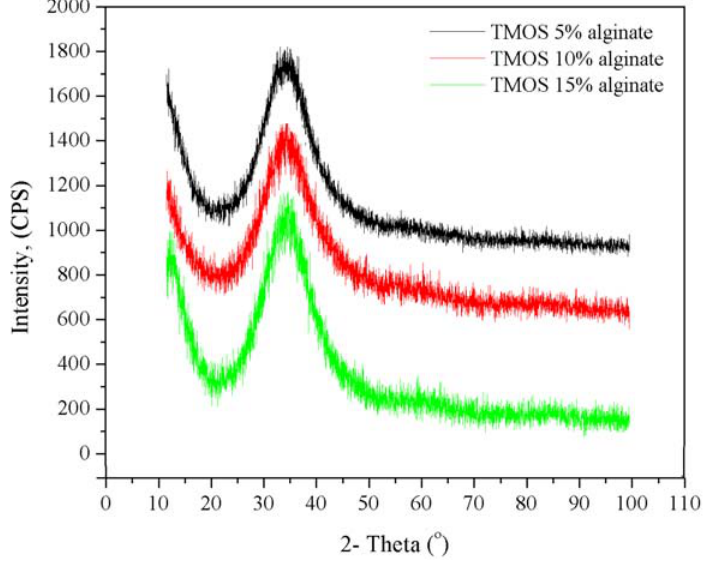
Fig. 2 XRD patterns of silica nanocomposite hybrids (TMOS) containing different quan- tities Calcium